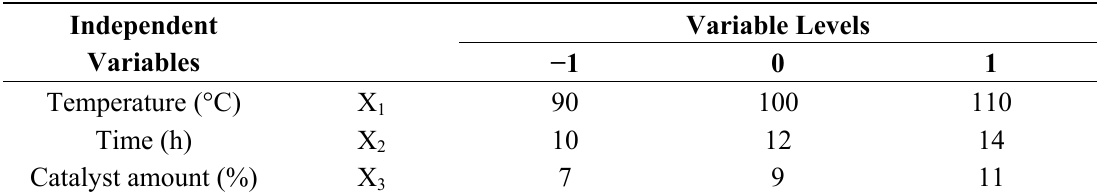
Table 1. Independent variables and their levels for Box-Behnken design of the hydrolysis reaction. Independent